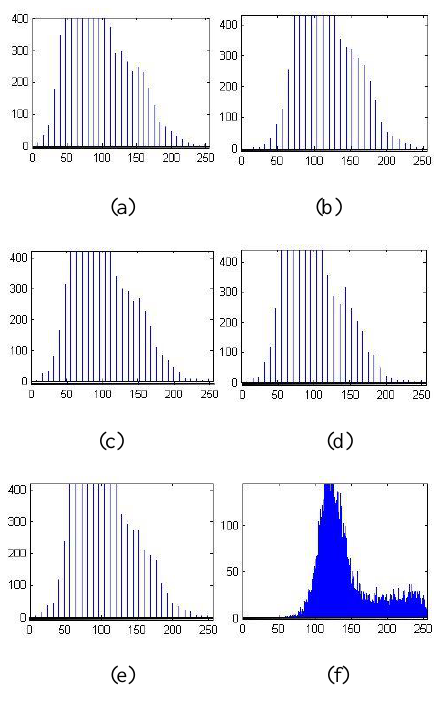
Figure 5. Figure(a), (b), (c), (d) and (e) represent the histogram of the five frame sequence images respectively, and figure(f) shows the histogram of the fused image. Due to the scattered information in single-frame PMMW images, the information of the concealed objects cannot be directly segmented. As shown in Figure 5(f), through the relevant screening, wavelet fusion and mean filter processing these images can make the image background and hidden information